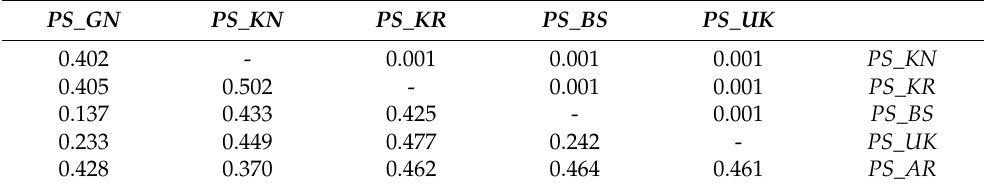
Table 4. Paired PhiPT genetic distances between the studied populations of P. sylvestris by AMOVA.